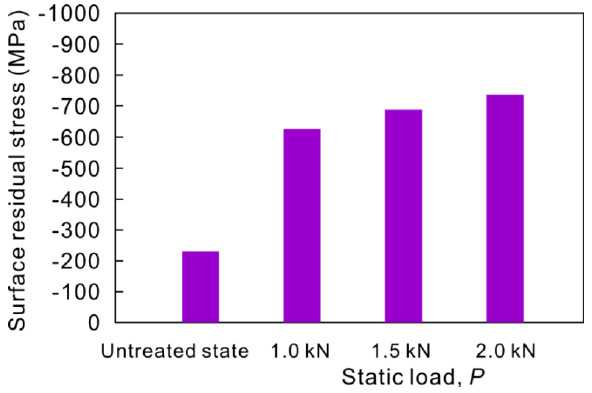
Figure 5. Surface residual stress of the untreated and USRP-treated specimens with different static loads P . The surface residual stress is the average value of several measurements.